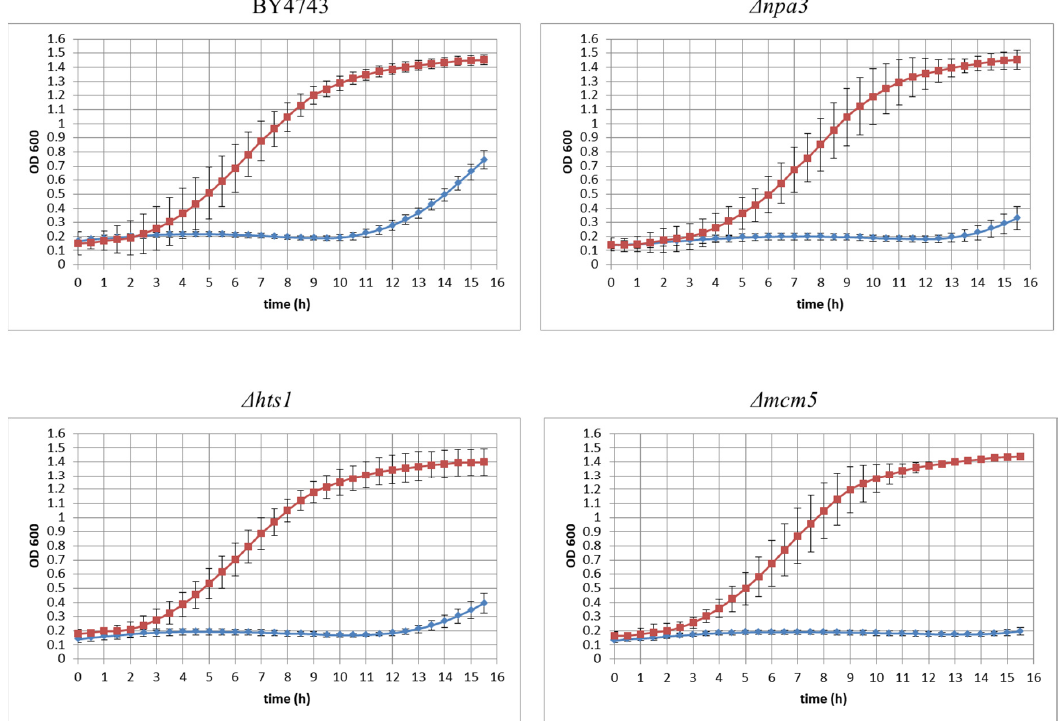
Figure 5. Effects of allicin (50 μ M) on the growth of wildtype BY4743 and Δ npa3 , Δ mcm5 and Δ hts1 mutants in CSM (complete supplement medium). The red line in each graph represents the untreated (culture in CSM only) and blue line shows the treatment with 50 μ M of allicin. There is greater difference between treated and untreated in case of hypersensitive yeast mutants as compared to BY4743. The experiments were repeated twice with similar results. Error bars show standard deviation about the mean.